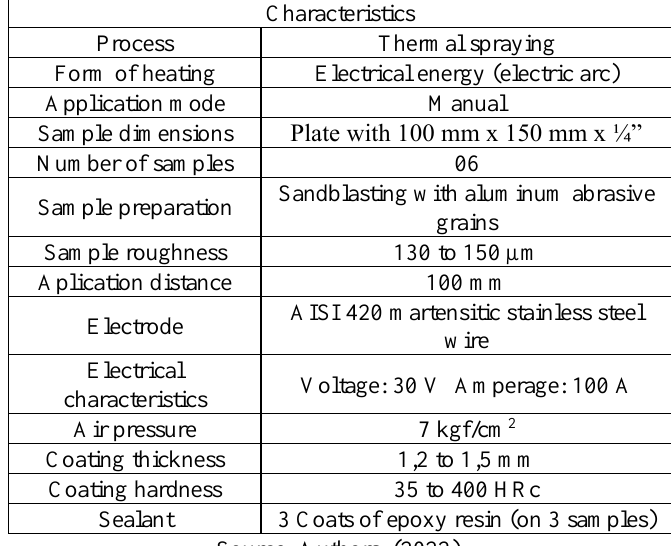
Table 2: Coating process characteristics.